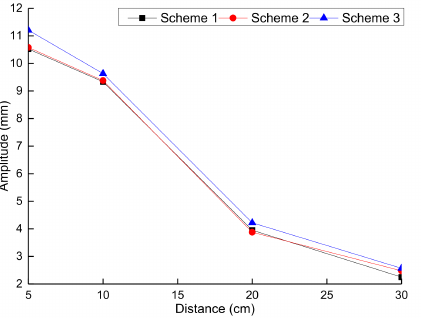
Figure 16. Average amplitude change with the installation